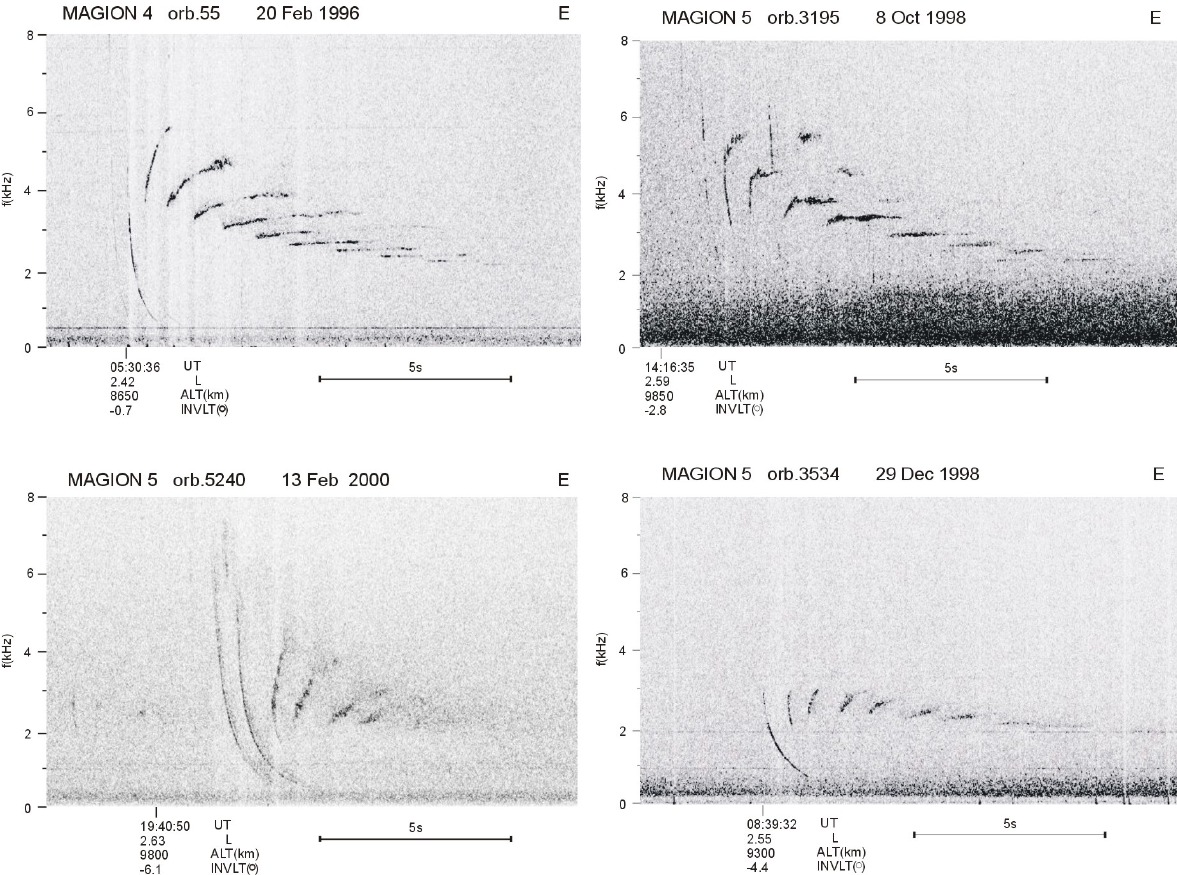
Fig. 2. Types of MR whistler spectrograms most frequently received at MAGION 4 and